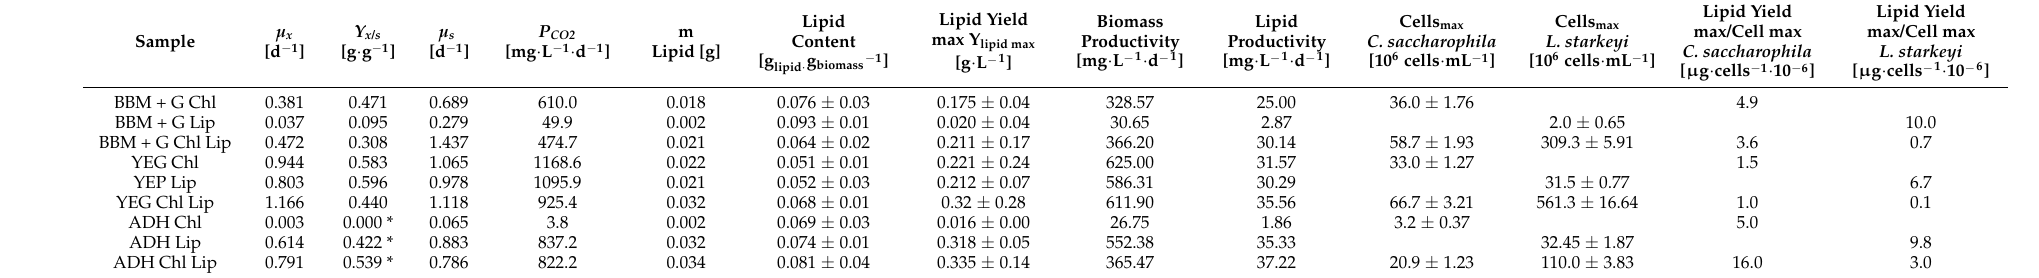
Table 1. Growth characteristics of the mixed cultures and the strains alone in BBM + G, YEG media and Arundo donax hydrolysates. Data shown as mean ± SD, n = 3.